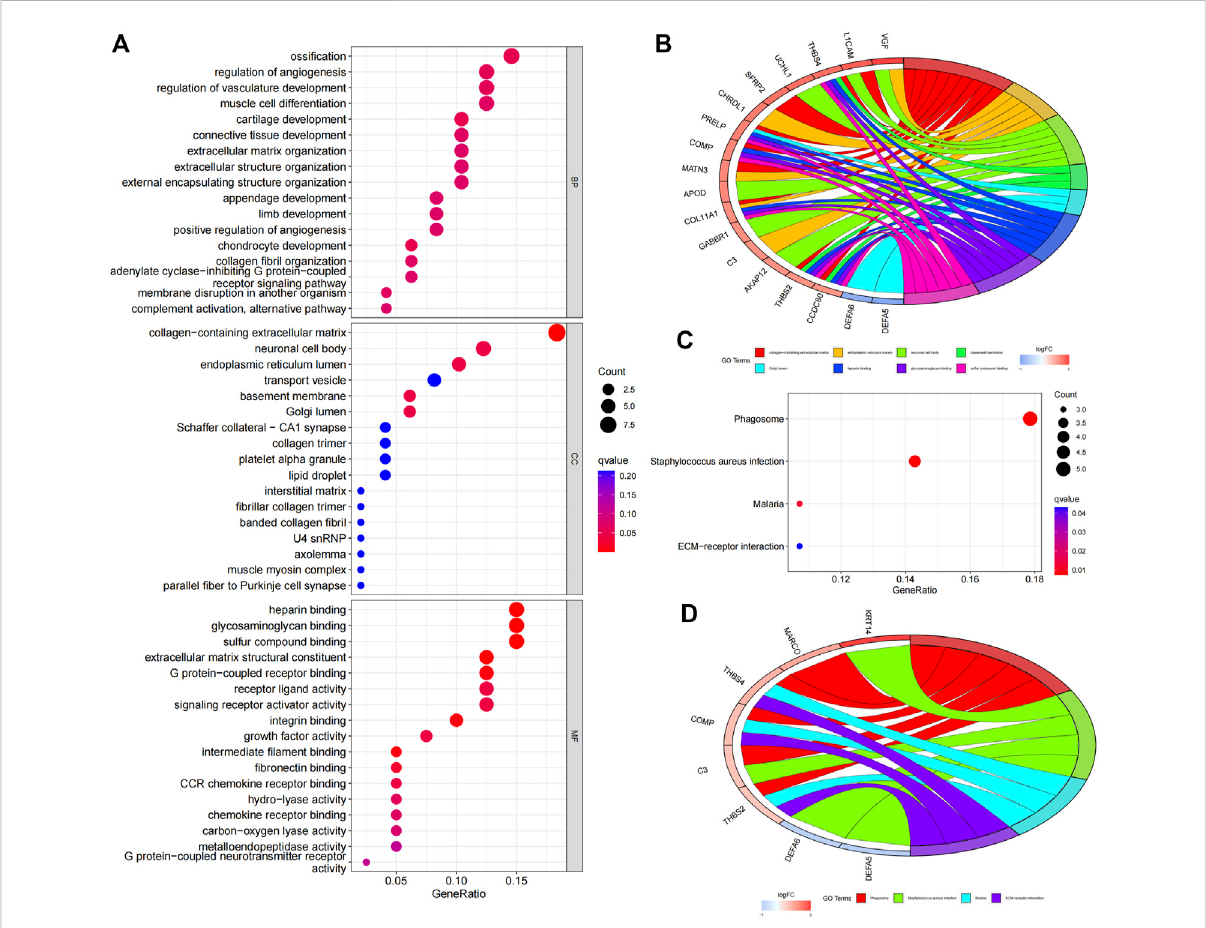
FIGURE 4 Functional enrichment analyses of the FAM-related gene signature. (A) GO analysis reveals biological process (BP), cellular components (CC), and molecular function (MF). (B) GOcircos of the genes enriched in different GO terms. (C) KEGG enrichment analysis of the risk signature. (D) KEGGcircos of the genes enriched in various KEGG